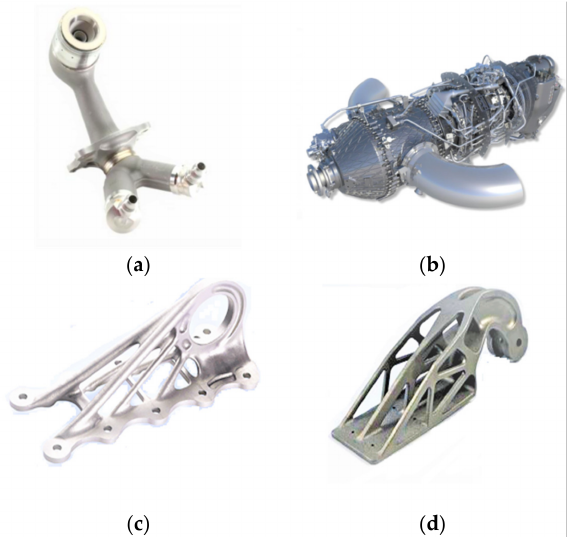
Figure 5. Aerospace additive manufactured components [77]: ( a ) GE Leap Nozzle, ( b ) GE Turboprop Engine, ( c ) Airbus A350 XWB jet wing bracket, and ( d ) Titanium door